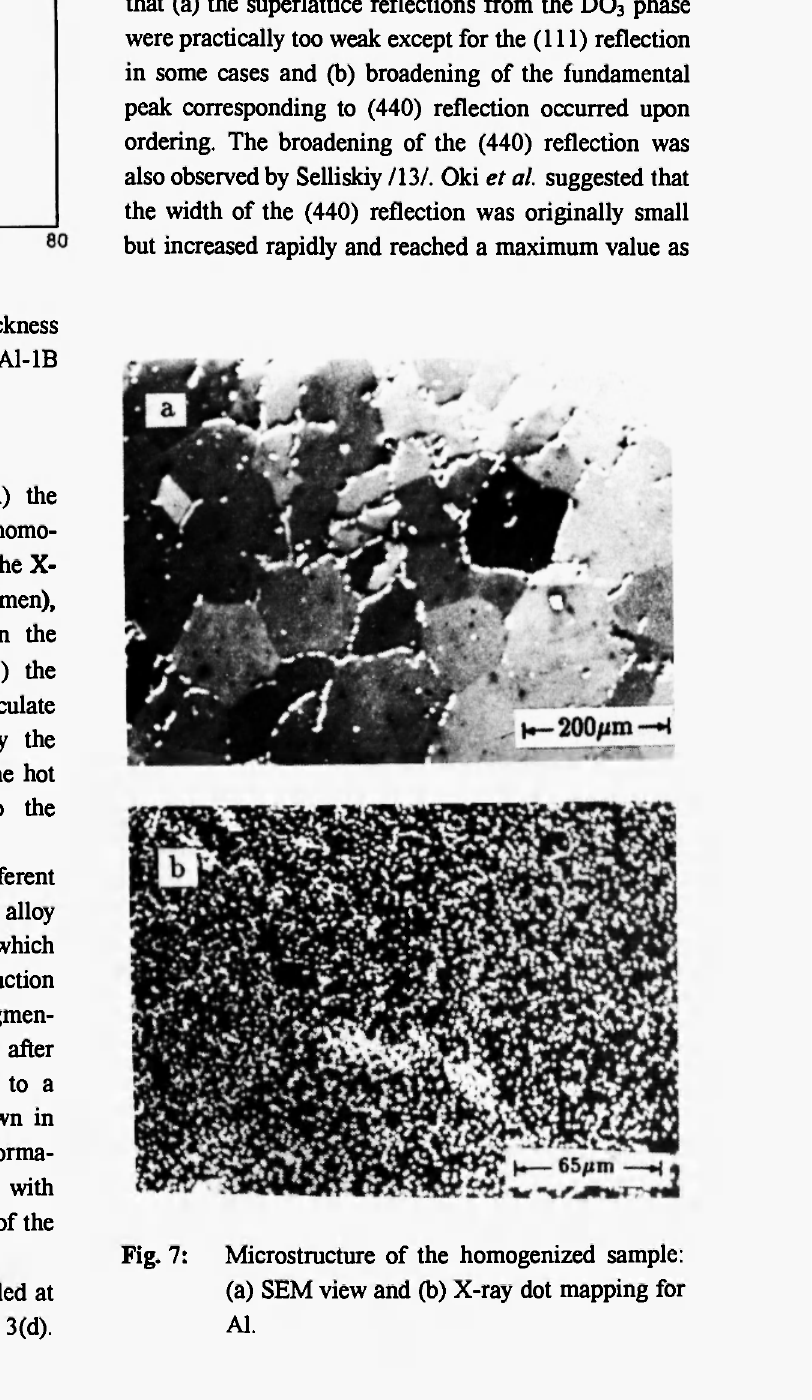
Fig. 6: Plot of aspect ratio of grains vs thickness reduction for the specimens of Fe-25A1-1B alloy rolled at 1373K.